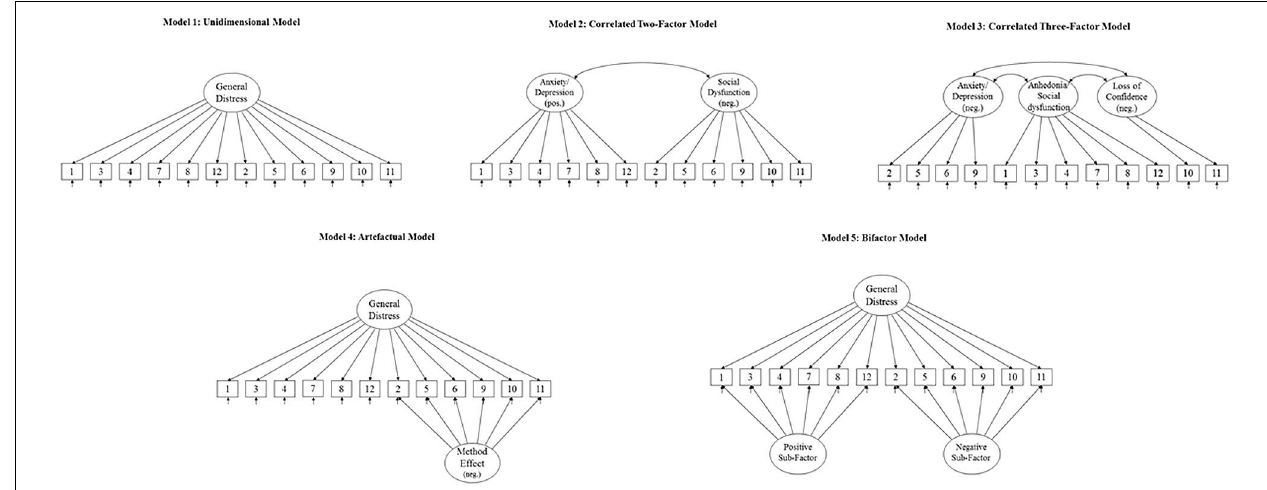
FIGURE 1 | The different factor models for GHQ-12 tested and